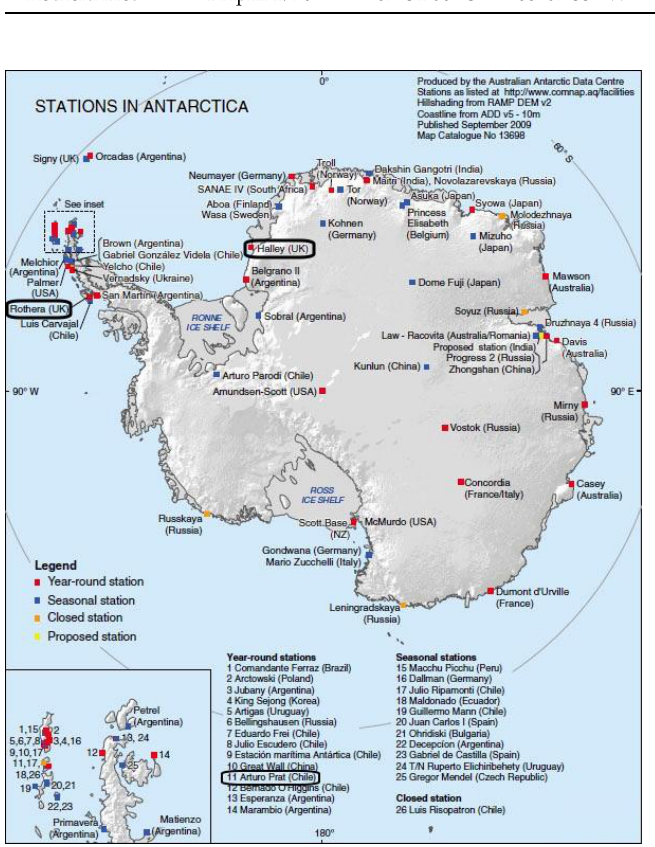
Figure 1. Map of Antarctic Peninsula and position of the analyzed stations (positions are indicated by the